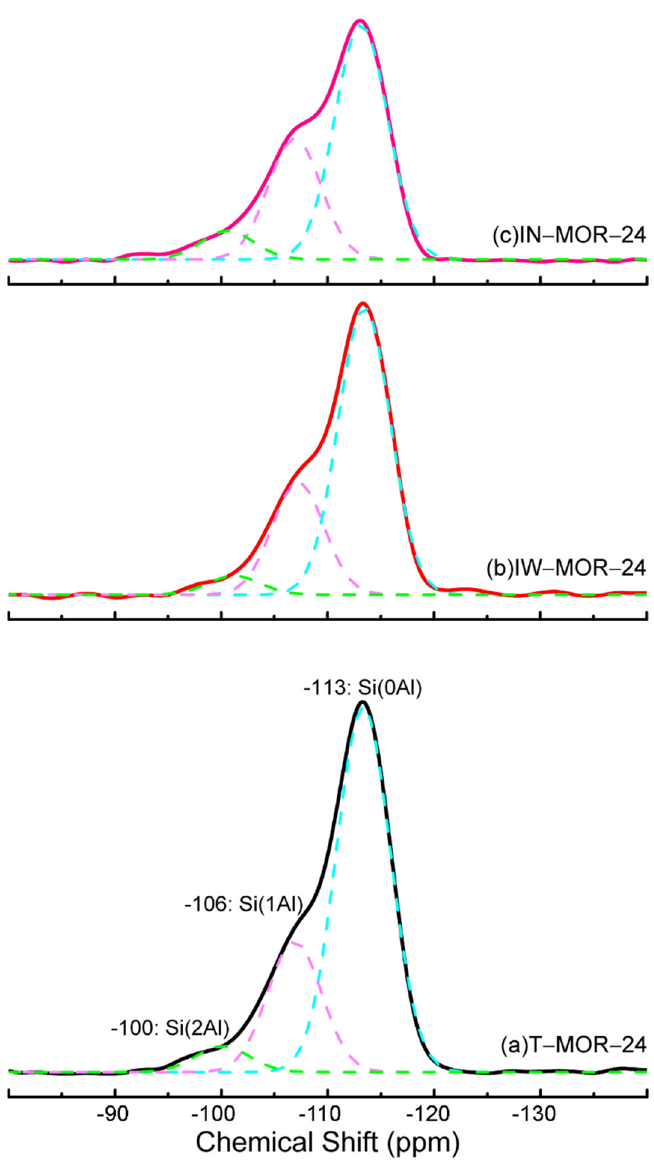
Figure 10. 29 Si MAS NMR spectra of ( a ) T–MOR–24, ( b ) IW–MOR–24, ( c ) IN–MOR–24 samples.